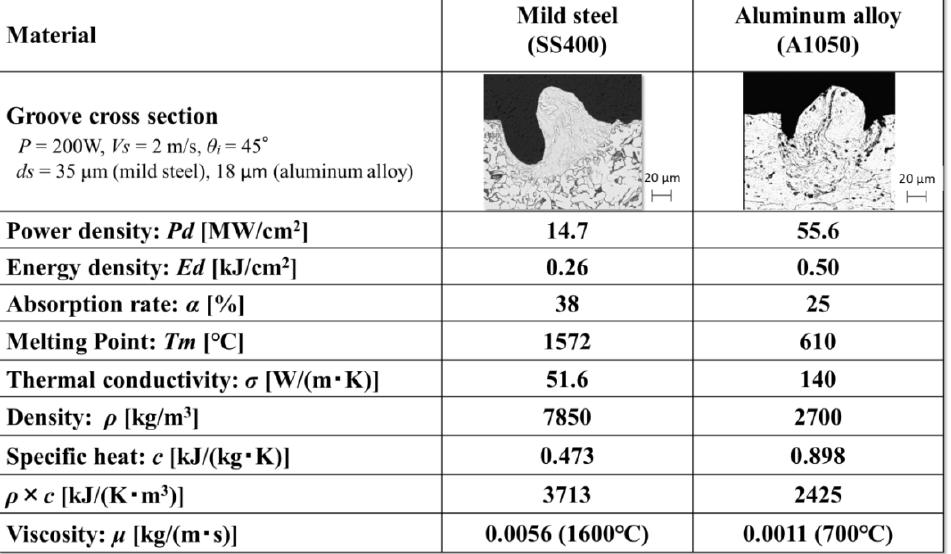
Figure 10. Comparison of micro-grooves and thermophysical properties of mild steel and aluminum ◦ , and V = 2 m / alloy ( P = 200 W, θ i = 45°, and V s = 2 m/s). alloy ( P = 200 W, θ i = 45 s